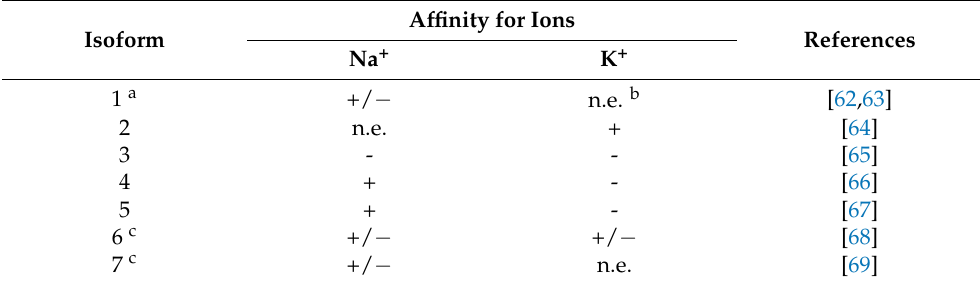
Table 1. The affinity of individual Na + /K + -ATPase (NKA) isoforms of FXYD subunits for Na + and K + ions. Affinity for Isoform